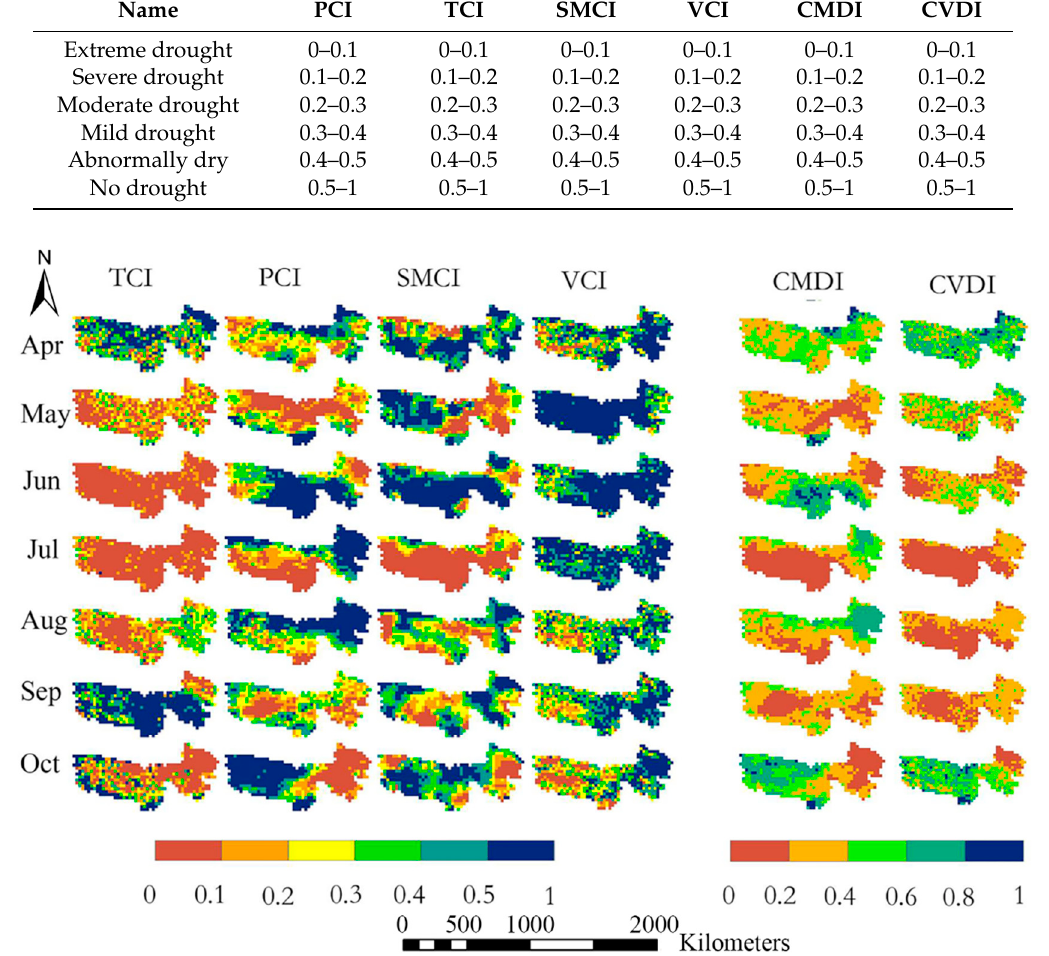
Figure 3. Seasonal changes of drought monitored by CI-based (Condition Index-based) drought indices from April to October in 2006. Table 3. Classi fi cation of drought severity for the CI-based drought indices used in this study.